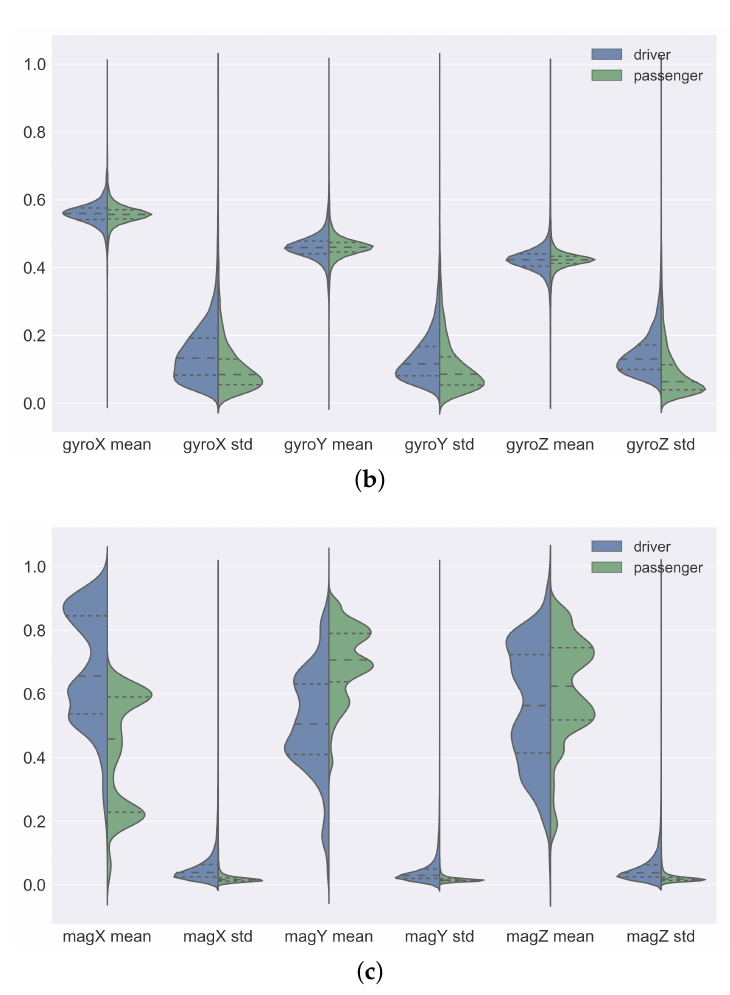
Figure 5. Violin Plot of the distribution of features computed from the sensor data. ( a ) Violin Plot of the distribution of features of accelerometer and GPS sensor data. ( b ) Violin Plot of the distribution of features of gyroscope sensor data. ( c ) Violin Plot of the distribution of features of magnetometer sensor